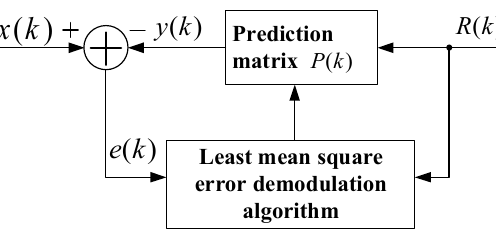
Figure 11. The functional block diagram of the least mean square demodulation (LMSD).